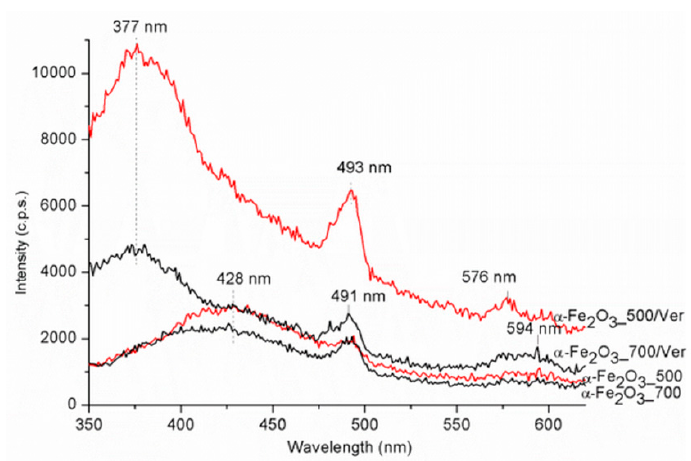
Figure 8. Photoluminescence spectra for α -Fe 2 O 3 nanoparticles pure and attached on vermiculite annealed at 500 °C and 700 °C.